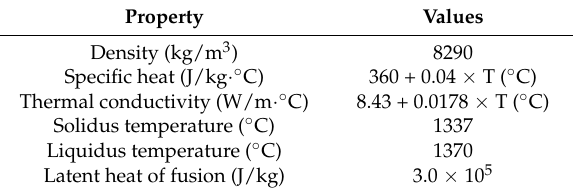
Table 3. Thermo-physical property parameters of IC10 used in numerical modeling.